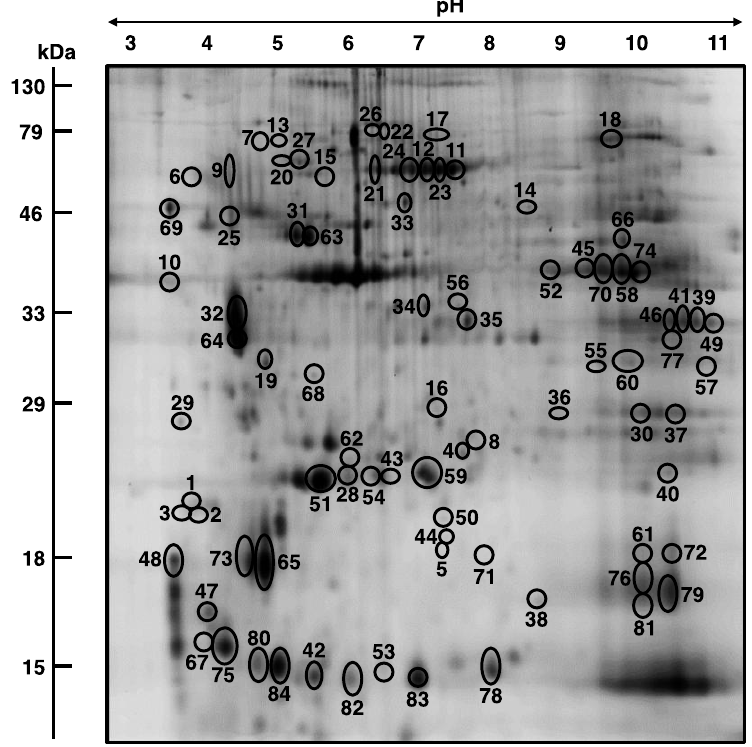
Figure 4. 2D-DIGE master gel of the aged mdx diaphragm muscle: Shown is a 2D master gel that is representative of the findings of the fluorescence two-dimensional difference in-gel electrophoretic analysis of the aged mdx diaphragm. Protein spots with a significant change in expression levels between normal and dystrophic specimens are marked by circles and are numbered 1 to 84. See Table 1 for the mass spectrometric identification of individual diaphragm-associated proteins. The pH-values of the first dimension gel system and molecular mass standards of the second dimension are indicated on the top and on the left of the panels,